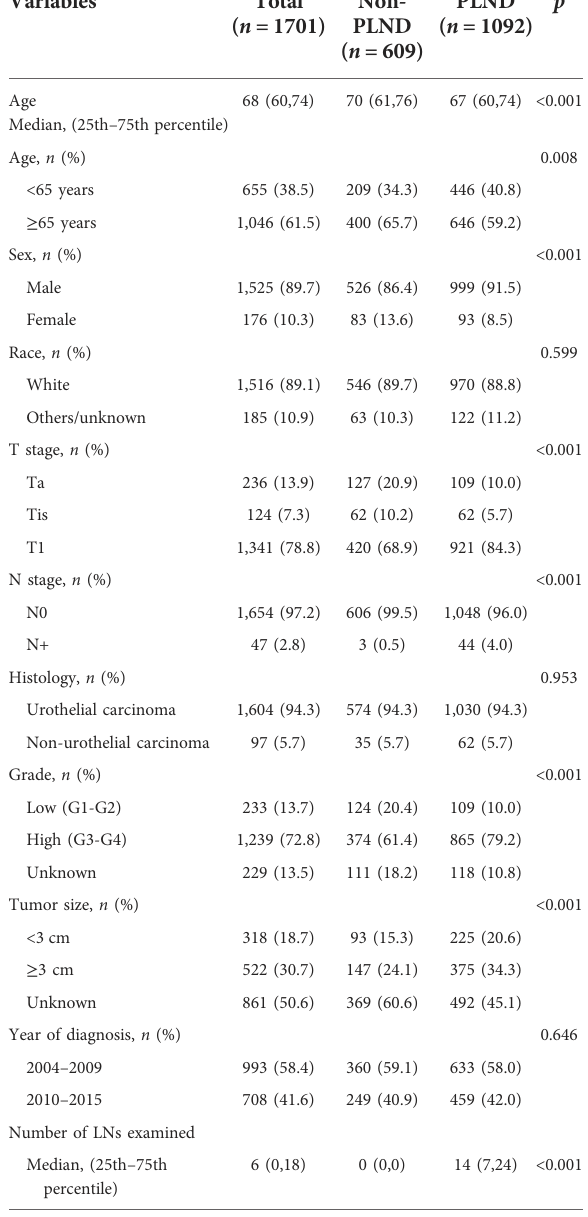
TABLE 1 Demographic and oncologic characteristics of the